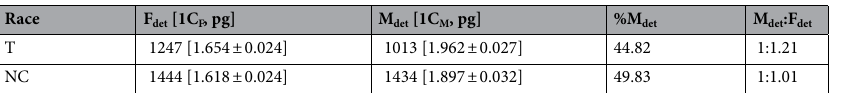
Table 1. Flow cytometric measurements of DNA content and frequency of male- and female-determining pollen grains in two R. hastatulus races ( T Texas, NC North Carolina). F det number of nuclei derived